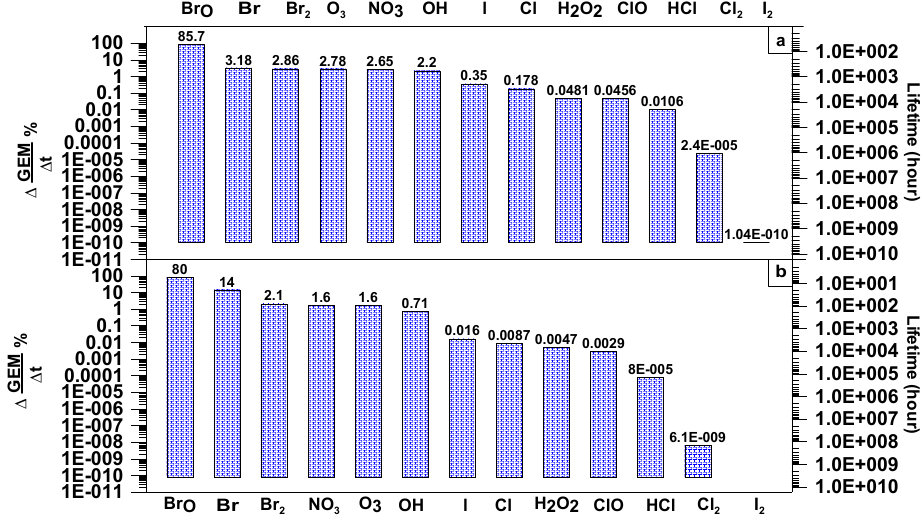
Fig. 6. Relative contributions of various oxidants to GEM depletion. Relative contributions (in %) of different species to GEM oxidation and associated GEM lifetimes for Julian days 201 (a) and 188 (b) , based on “BASE” simulation. Maximum mixing ratios of 20pmolmol − 1 were used for NO 3 .